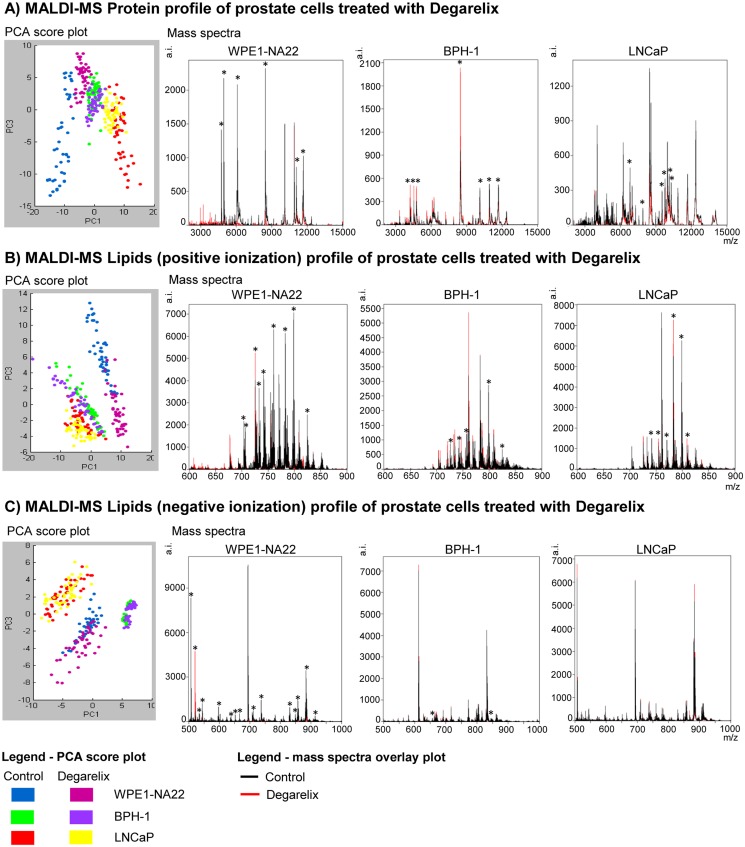
MALDI MS profiles.The profiles of prostate cells treated with degarelix for the protein (A) and lipids acquisition in positive (B) and negative polarity (C). Each acquisition shows the PCA score plots of all data originating from each sample group from the respective analyses. The average mass spectra comparisons of the control versus treatment for each sample type and acquisition type (black indicates the control, red indicates treatment, and the asterisks highlight differentially expressed signals).